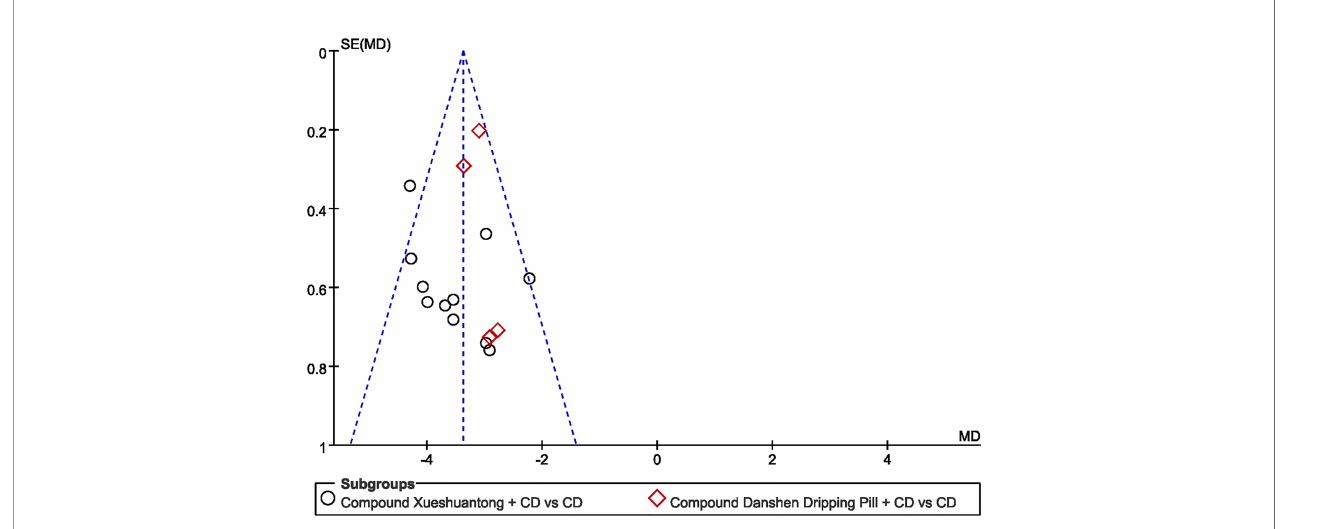
FIGURE 9 | Funnel plot of the trials that compared CPMs plus CD group with CD group; Microaneurysm